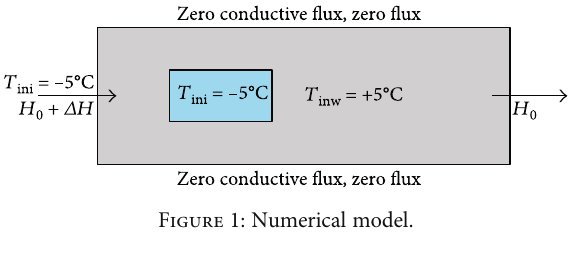
Figure 1: Numerical model.